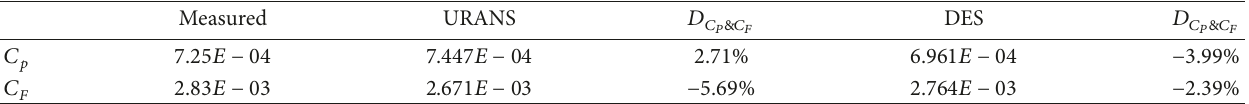
Table 3: Validation of ship resistance coefficients by experimental